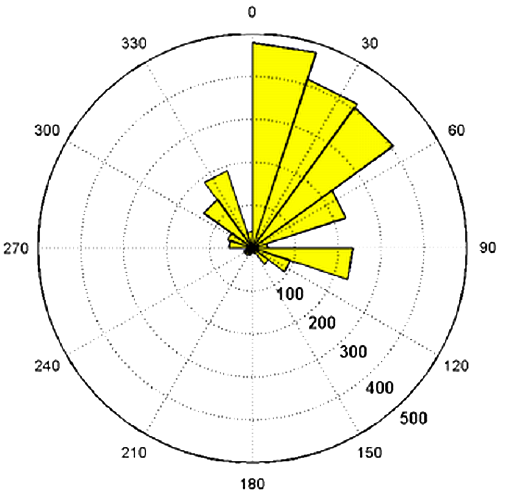
Figure 6. Wind directions during dust events in S Iceland in